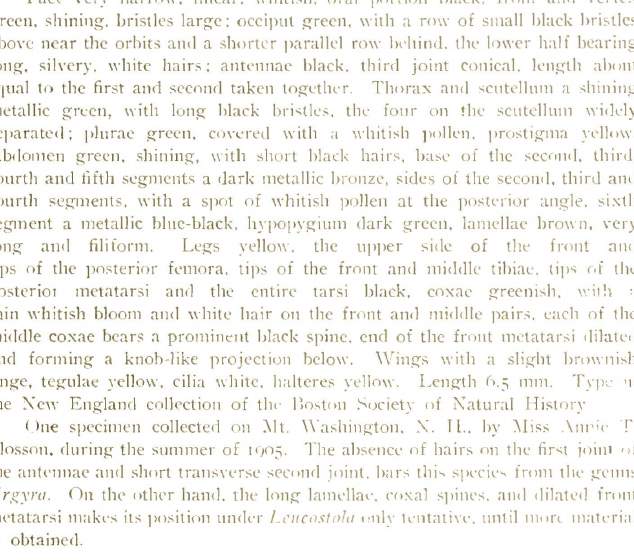
DESCRIPTIO:\S OF T\\'0 :\E\\' DIPTER.\ OF THE f.-\:-.IILY DOLICIIOPODID. \E. UY CHARLES W. JOHr-;SO:-.i. Leucostola slossonac n. sp. Face Ycry narn>IY, linear. whitish. oral portion hbck. fr .. tll and Yertex green, shining. bristles large: occiput green. with a row of small black